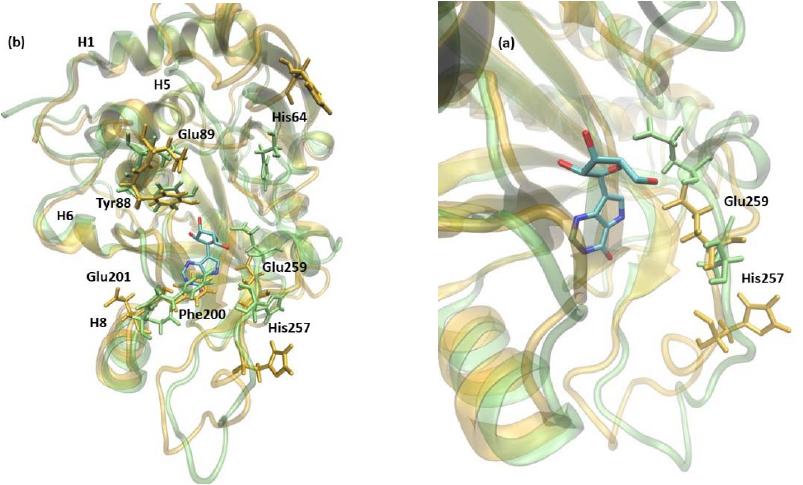
Figure 8. The shift of active site amino acids observed in the structure of 6Ala1 PNP (yellow), in comparison with the WT3 PNP (green). The substrate analogue (9 ‐ deazainosine) bound to the bio ‐ logically active WT3 PNP is also shown (colored by the atom types) to better visualize the changes in the geometry of the active site pocket occurring in the 6Ala1 PNP. The ligand was not present in the simulations, and its location is from the X ‐ ray structure of the WT PNP trimer (PDB 1A9P [21]). Changes are similar to those already observed for the WT1 PNP and include residues His64, Tyr88, Glu89, Phe200, and Glu201 ( a ) (compare with Figure 5). In the 6Ala1 PNP monomer, His257 addi ‐ tionally moves away from the active site, as the adjacent helix partially unwinds. Glu259 also changes its position in the 6Ala1 mutant, as shown on the focus to this area, depicted in panel ( b ). Overall, this destabilization of the active site observed in the simulations of the 6Ala1 PNP again, as in the case of WT1 PNP, suggests that the monomeric form of the protein is incapable of catalysis. 2.2.2. 6Ala3 PNP vs. WT3 PNP Because the mutated monomer displayed different locations of the active site residues, we further checked in silico if incorporating the same mutations to the PNP trimer would influence the conformational stability of such an assembly. Therefore, the molecular dynam ‐ ics simulations of the trimeric PNP with six mutations (6Ala3 PNP) were executed. Introducing mutations to the WT trimer did not drastically change the RMSD, such as in the case of both monomeric enzyme forms. As depicted in Figure 2a, the RMSD values plotted as a function of the simulation time, for both structures WT3 PNP (black line) and 6Ala3 PNP (blue), stabilize over the last 50 ns of the simulation at the level of about 2 Å. Additionally, fluctuations of the 6Ala3 PNP are much smaller than those observed for the WT1 and 6Ala1 PNP forms. However, in the mutated trimer, an increase in fluctu ‐ ability of certain parts of the protein is observed, namely in the regions 32–38, 59–66, and 82–94 (Figure 9). These regions also exhibit larger fluctuations in the 6Ala1 mutant; how ‐ ever, some of the regions characterized by higher fluctuations for the 6Ala1 PNP are sta ‐ bilized in the structure of the 6Ala3 enzyme form.